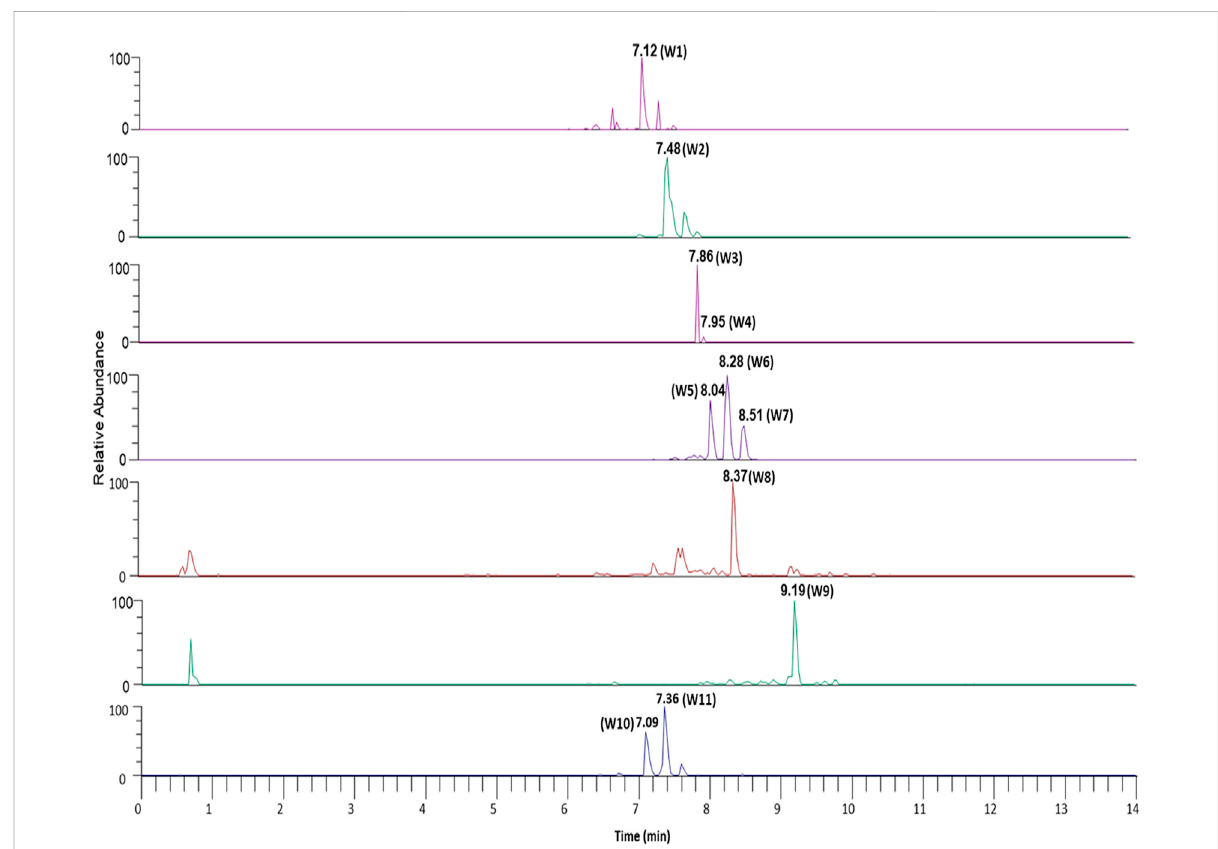
FIGURE 3 Chromatograms of identi fi ed phytoconstituents of W ithania somnifera comprising W (1 – 11); withanoside VII (W1), viscosalactone B (W2), dihydro withaferin A (W3), withanoside V (W4), withaferin A (W5), 12-deoxywithastramonolide (W6), withanolide A (W7), 27-hydroxywithanone (W8), withanolide B (W9), withanoside X (W10), and coagulin Q